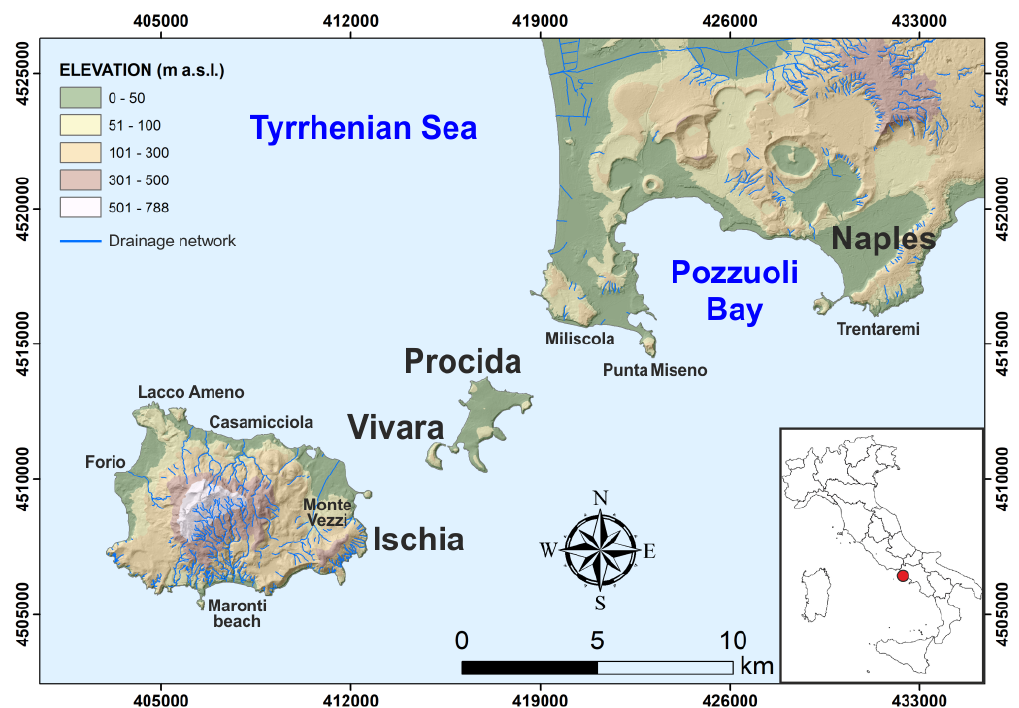
Figure 1. Location (red dot in the inset map) and shaded relief of the Campi Flegrei volcanic area including the islands of Ischia, Procida, and Vivara (coordinates in EPSG 32633). The shaded relief has been developed from elevation data of the SIT Regione Campania (for reference see the main